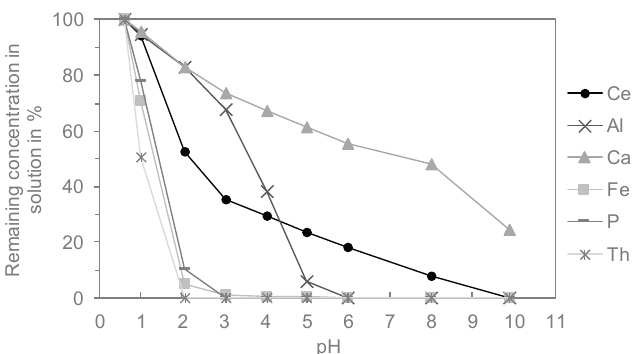
Figure 21. Purification of the leachate solution with high impurity content. Ammonium solution (10 wt%) was used as precipitation agent.